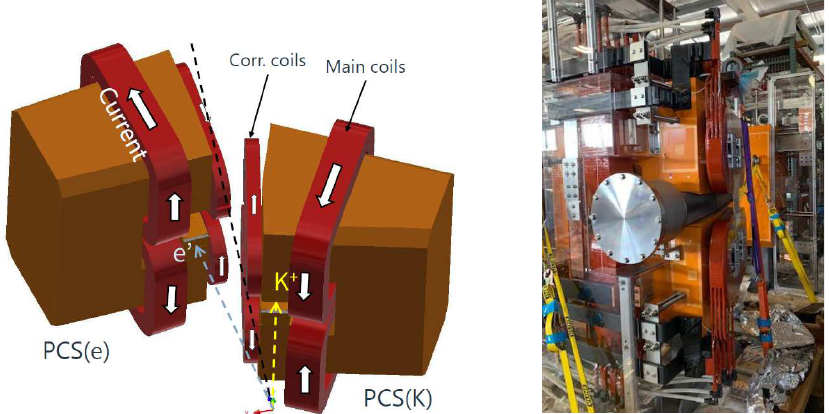
Figure 5. Particle Charge Separator (PCS) consists of a pair of dipole magnets (left). PCS(e) can bend 3 GeV / c electron by 6 degrees and PCS(K) can do 1.2GeV / c K + by 18.4 degrees. They were constructed in Japan and shipped to JLab in 2022